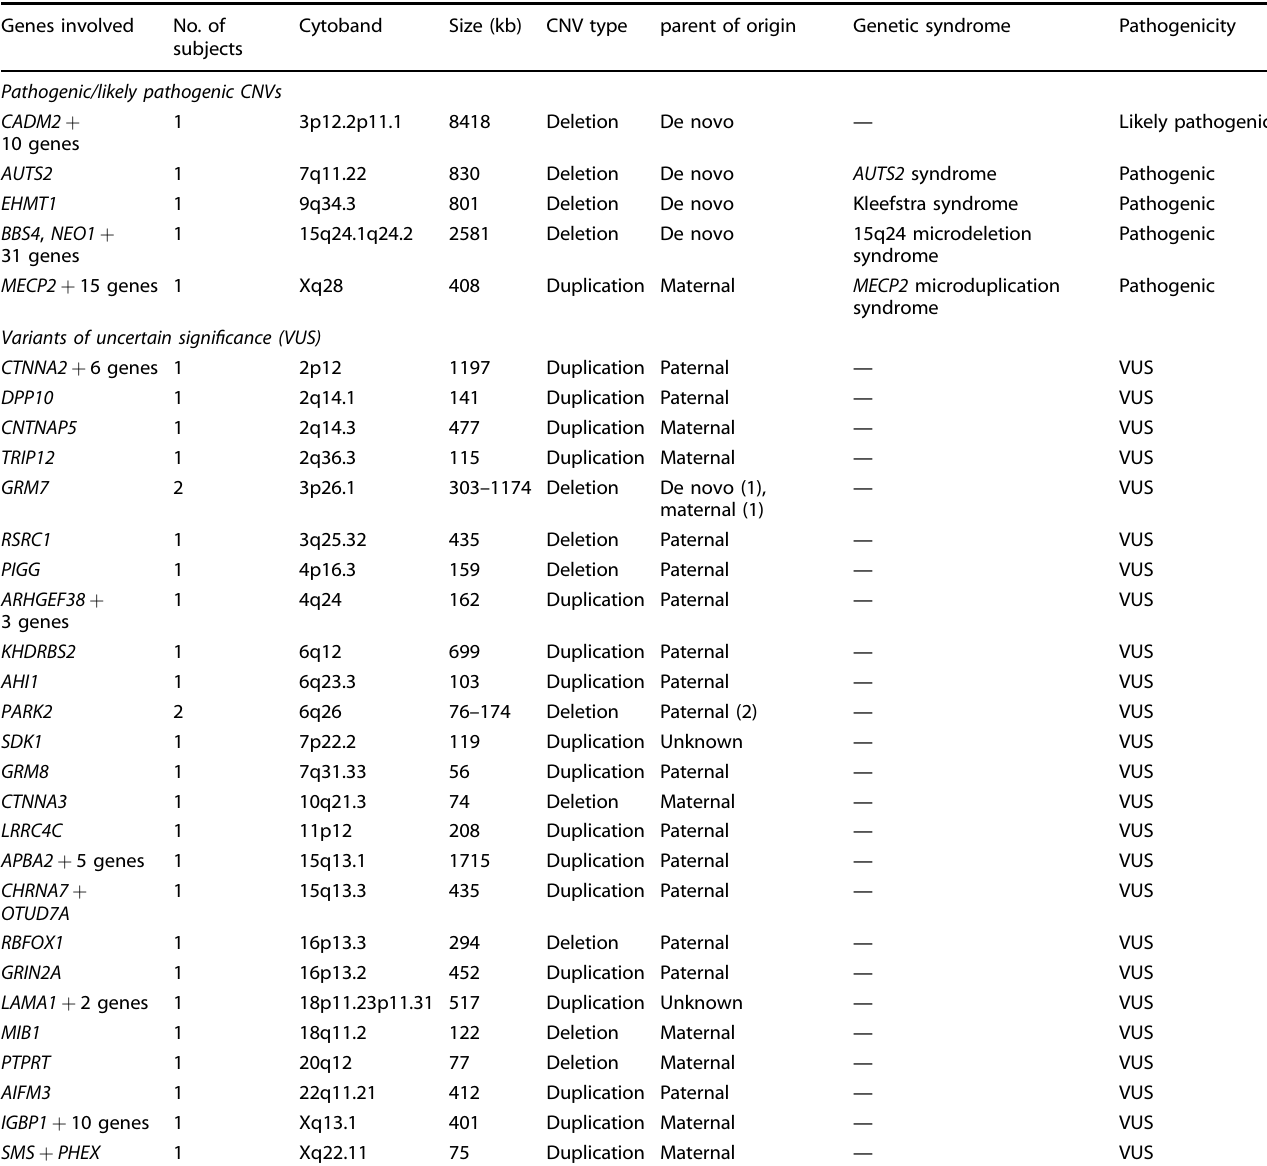
Table 2. List of clinically relevant CNVs found in the patients with autism spectrum